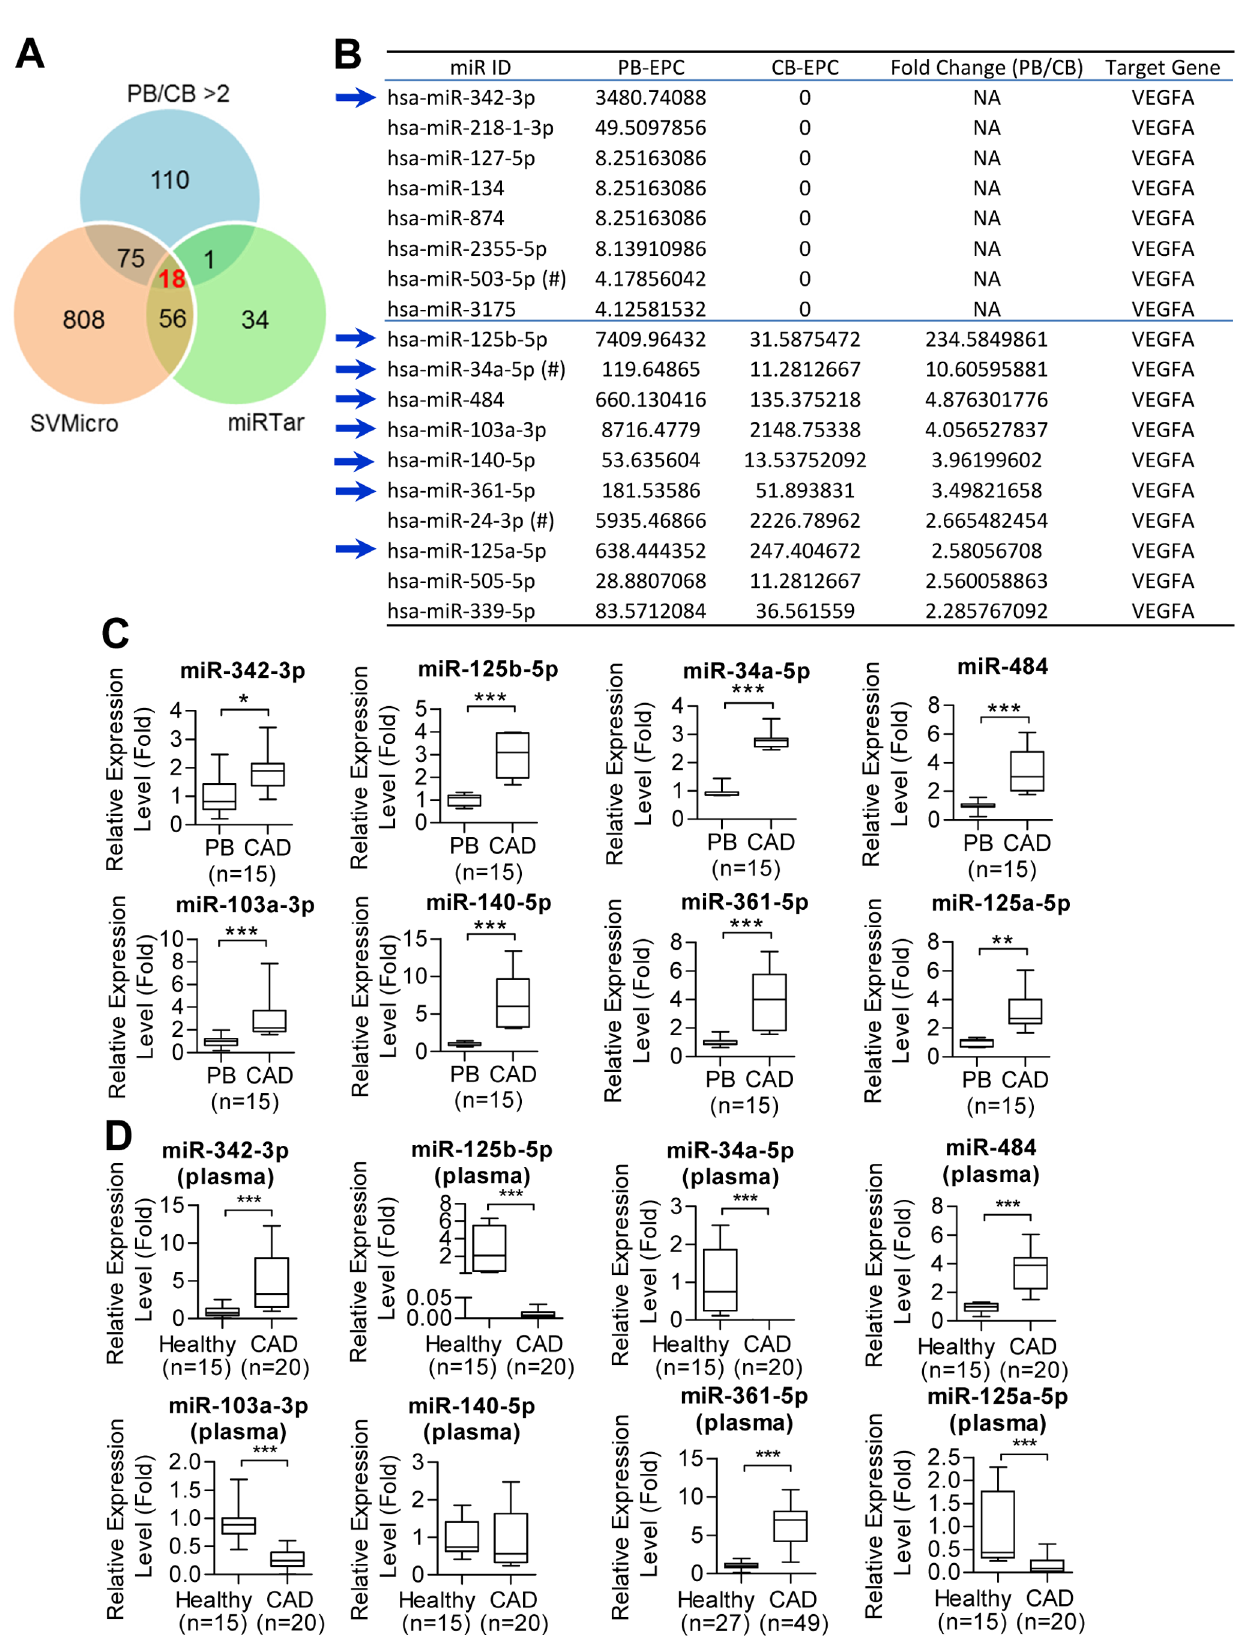
Figure 2. smRNA-seq reveals candidate anti-VEGF miRNAs in both EPCs and the plasma of CAD patients. ( A ) A Venn diagram showing overlapping miRNAs between smRNA-seq data and bioinformatics prediction results. ( B ) A table highlighting candidate VEGF-targeting miRNAs